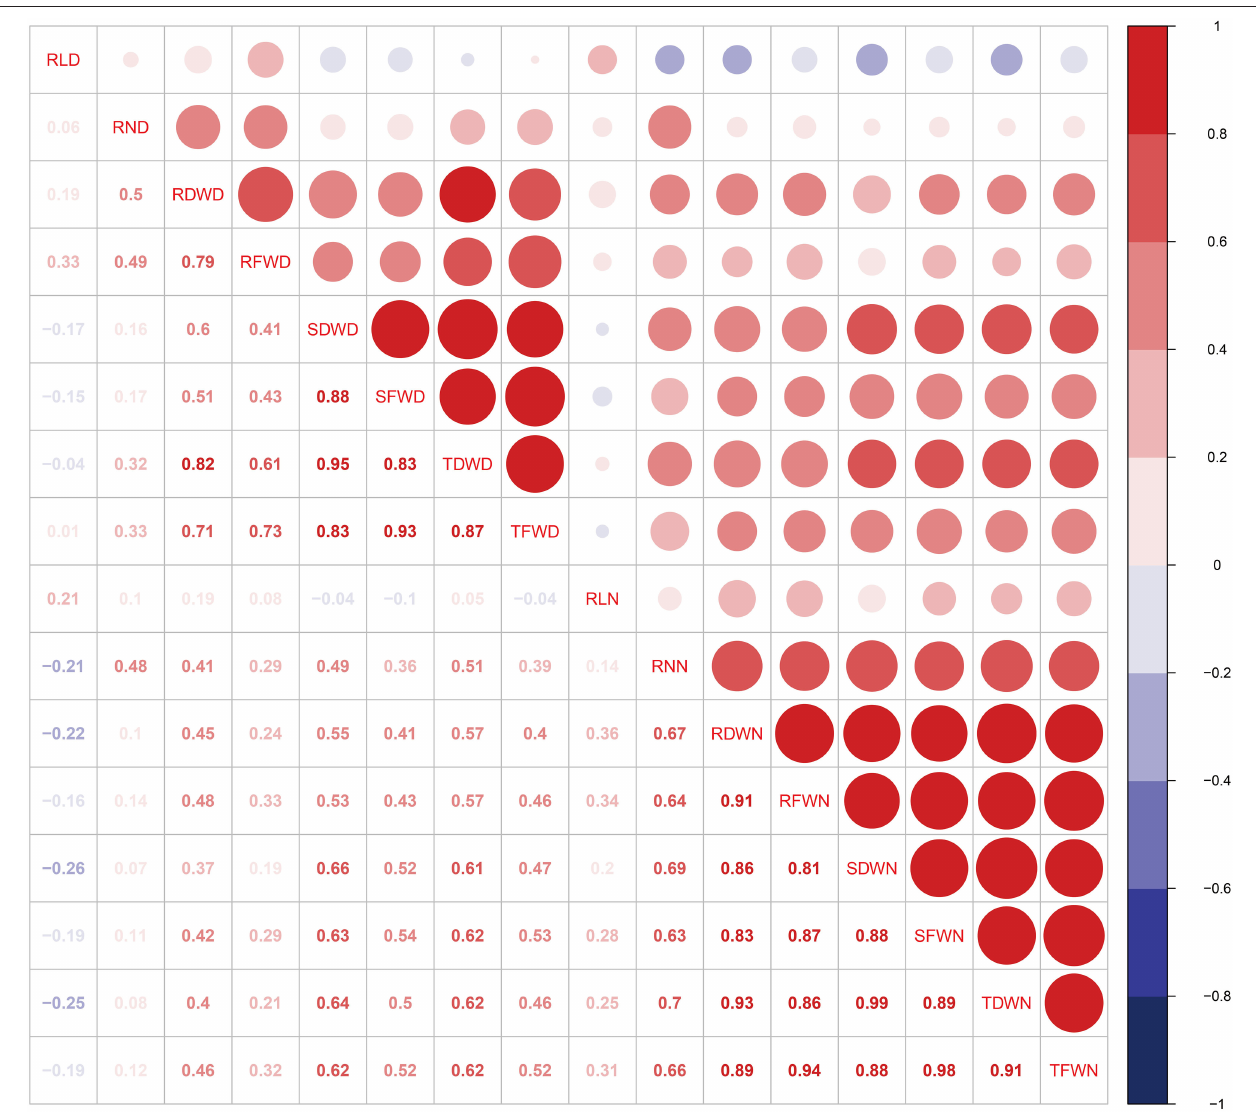
FIGURE 1 | Correlation analyses between eight root and seedling biomass traits for each environment. Trait abbreviations: RLD, root length in drought environment; RLN, root length in controlled environment; RND, root number in drought environment; RNN, root number in controlled environment; RDWN, root dry weight in controlled environment; RDWD, root dry weight in dry environment; RFWN, root fresh weight in controlled environment; RFWD, root fresh weight in dry environment; SFWN, shoot fresh weight in controlled environment; SFWD, shoot fresh weight in dry environment; SDWN, shoot dry weight in controlled environment; SDWD, shoot dry weight in drought environment; TFWN, total fresh weight in controlled environment; TFWD, total fresh weight in drought environment; TDWN, total dry weight in controlled environment; TDWD, total dry weight in drought